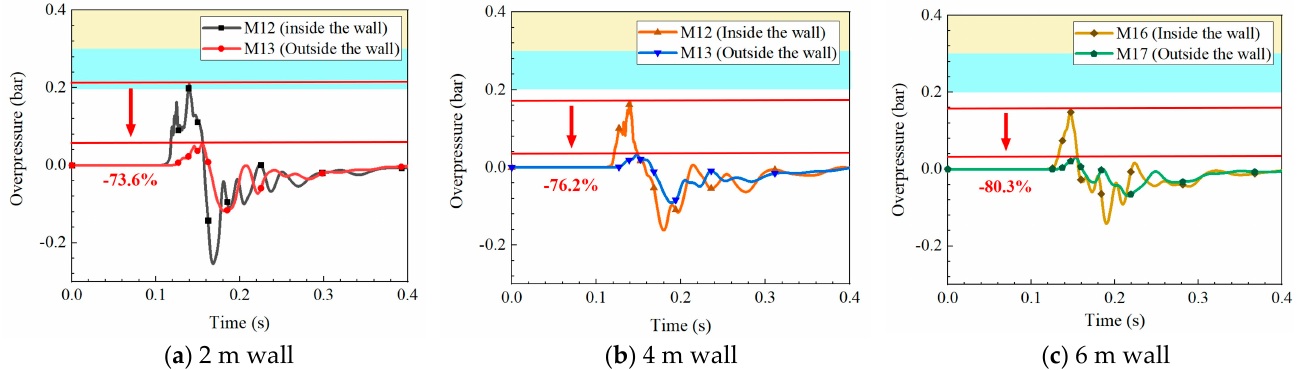
Figure 12. Evolution of the hydrogen overpressures at the back of the SHRS for various protective wall distances.